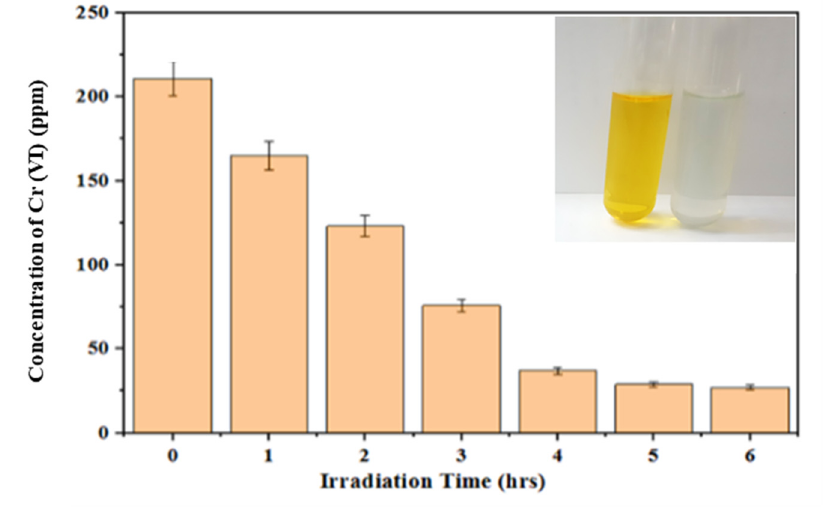
Figure 9. Decrease in concentration of Cr(VI) after solar photocatalytic reduction reaction.